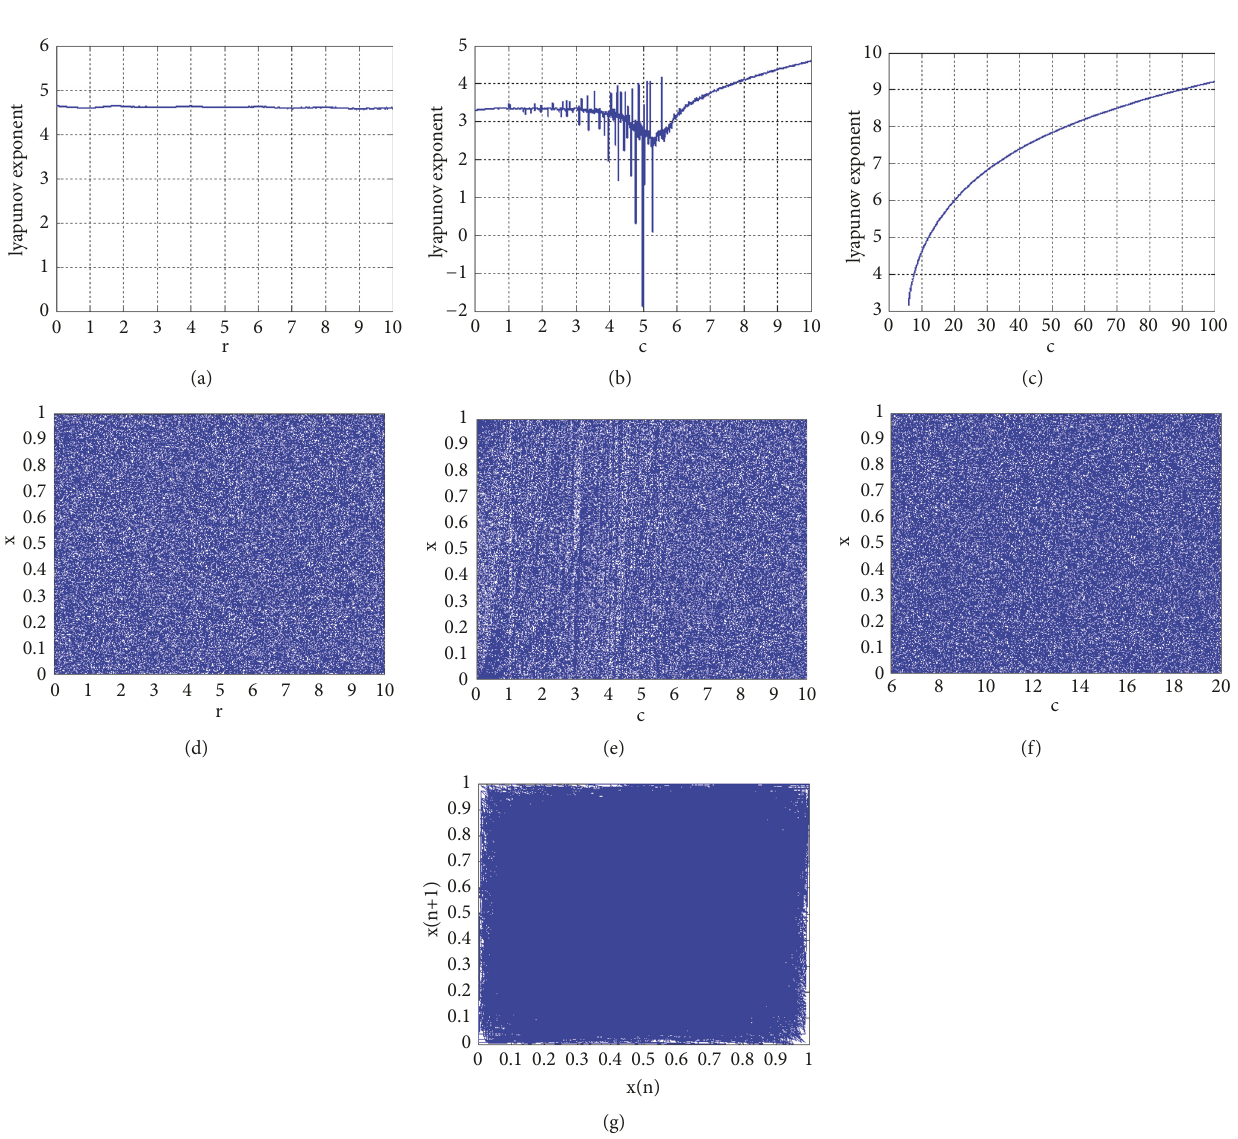
Figure 2: Dynamics of proposed chaotic map: (a) Lyapunov exponent vs 𝑟 ∈ [0,10] for c=10, (b) Lyapunov exponent vs 𝑐 ∈ [0, 10] for r =10, (c) Lyapunov exponent vs 𝑐 ∈ [6, 100] for r=10, (d) bifurcation vs 𝑟 ∈ [0,10] for c=10, (e) bifurcation vs 𝑐 ∈ [0,10] for r =10, (f) bifurcation vs 𝑐 ∈ [6,20] for r=10, and (g) attractor’s phase space for c = r